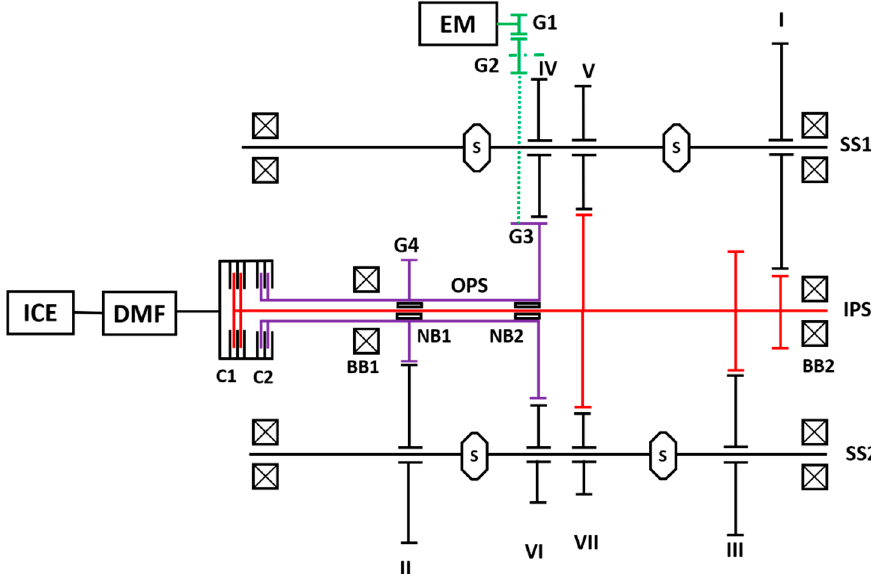
Figure 2. Stick diagram of a generic hybrid dual clutch transmission.